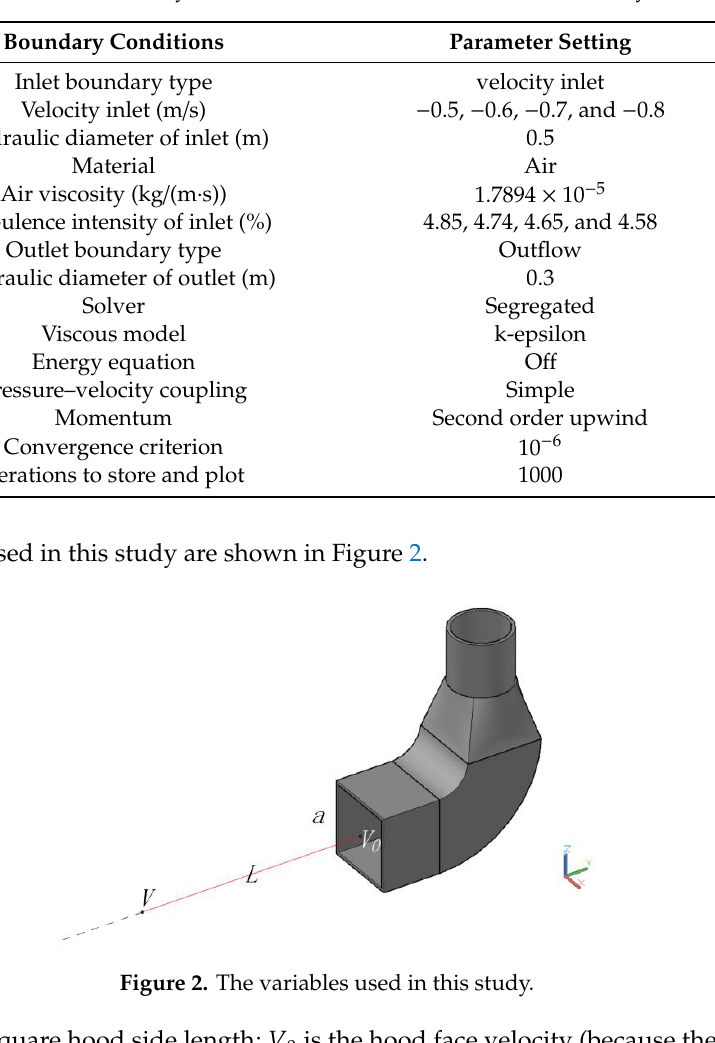
Table 1. Boundary conditions and solve define used in this study.